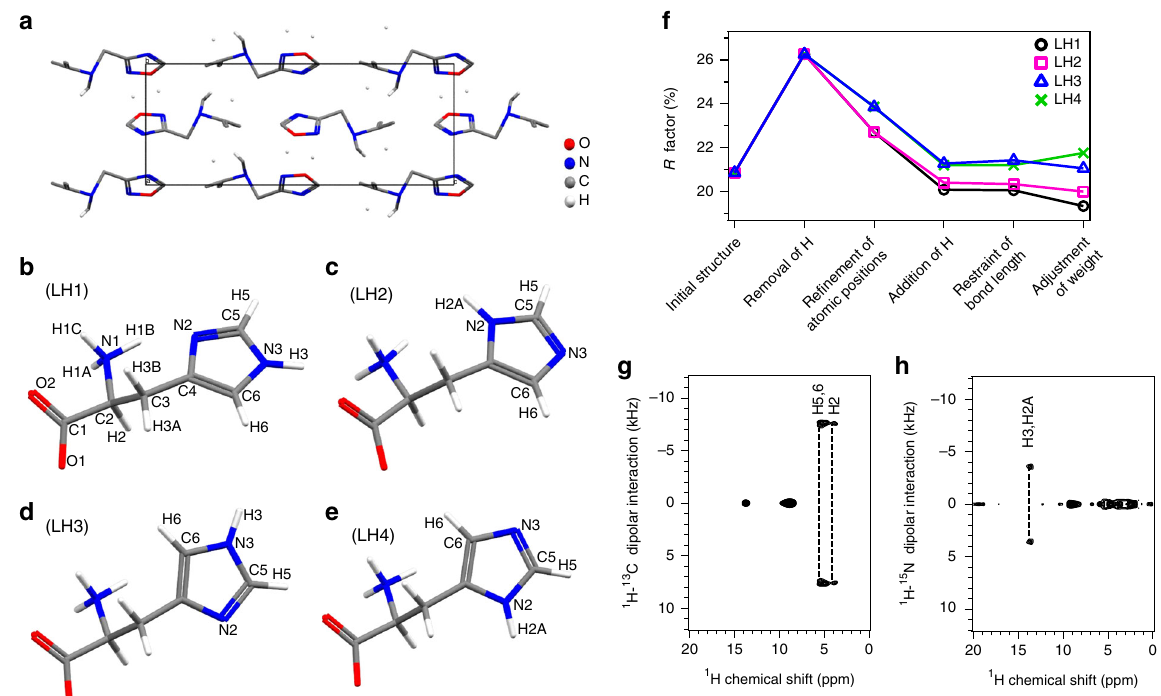
Fig. 2 Determination of L -histidine crystal structure using ED and SSNMR. a The initial structure was determined via ED using the rotation method. The structure is depicted in the bc plane and the R factor was 20.86% after solving using the SIR2014 software. The red, blue, gray, and white atoms denote oxygen, nitrogen, carbon, and hydrogen atoms, respectively. Four possible molecular structures of L -histidine (LH) are exhibited in b LH1, c LH2, d LH3, and e LH4 along with the atomic numbering scheme. Four models are considered based on the chemical formula (C 6 H 9 N 3 O 2 ). f Variation of the R factor (%) after each re fi nement step as determined using the SHELXL software. g 2D 1 H – 13 C and h 1 H – 15 N invCP-VC spectra. The number of scans was 176 for 1 H – 13 C spectrum and 112 for 1 H – 15 N spectrum. The 1 H – 13 C dipolar couplings obtained at 1 H chemical shift of 3.87 and 5.25 ppm were 15.19 and 15.40 kHz, respectively. The 1 H – 15 N dipolar coupling obtained at 1 H chemical shift of 14.31 ppm was 7.11 kHz